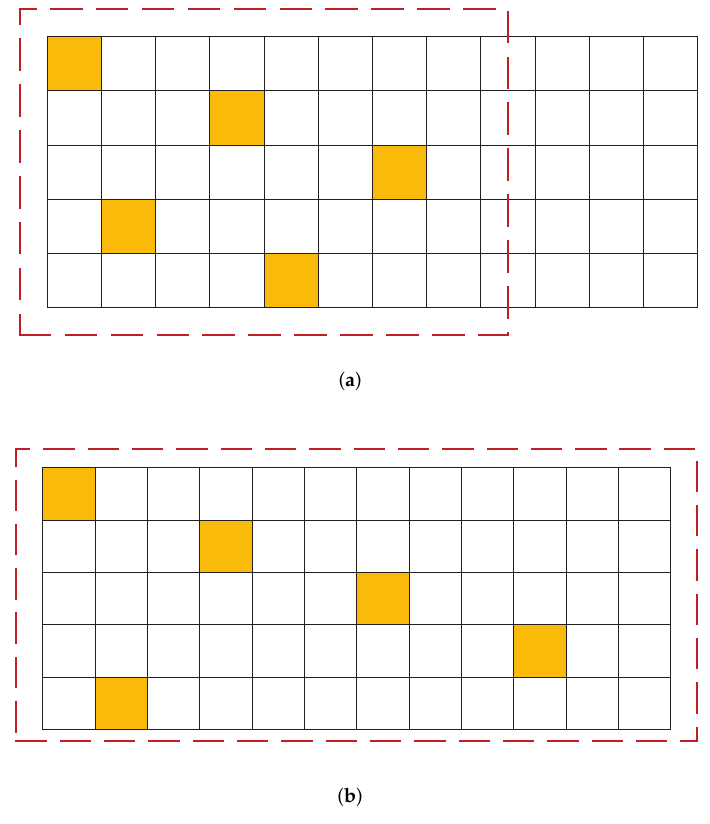
Figure 3. Cyclic shift design. ( a ) p t = 3, Q = 8; ( b ) p t = 3, Q =